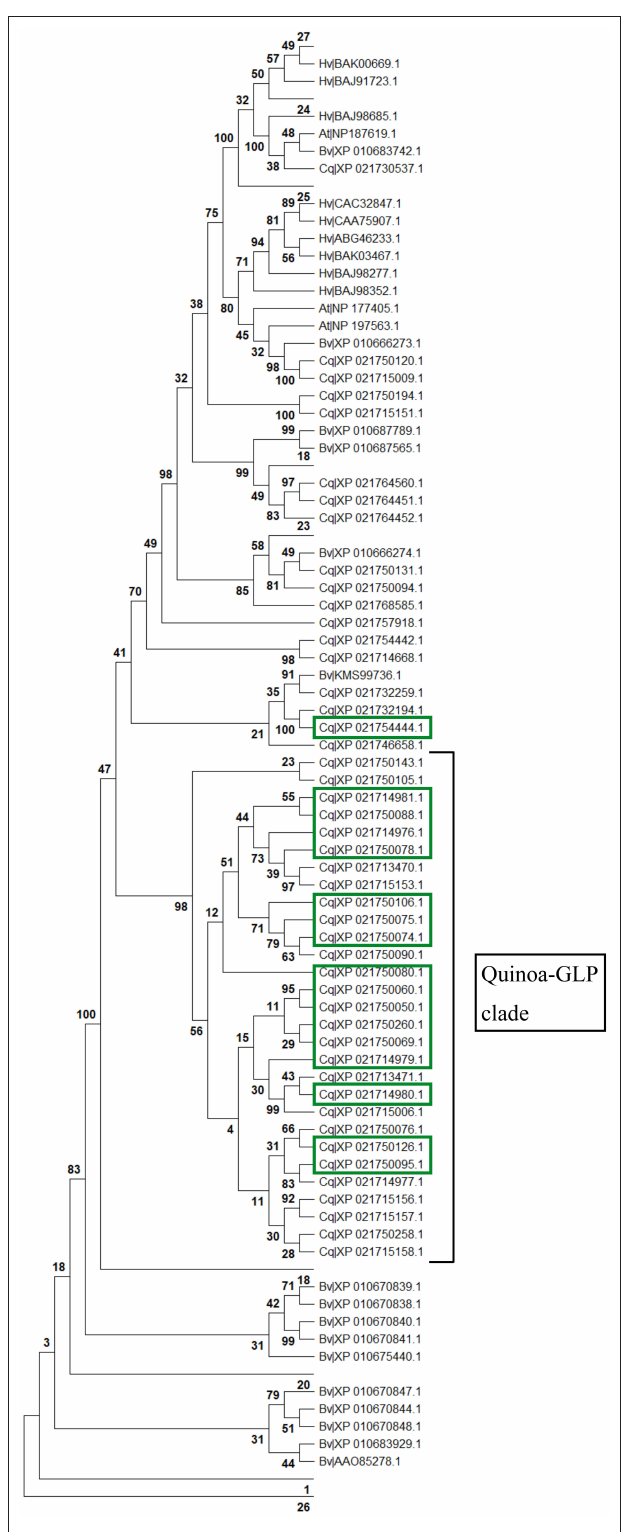
FIGURE 6 | Protein evolutionary tree of germin and germin-like proteins. All identified germin-like proteins found in C. quinoa (Cq), B. vulgaris (Bv),